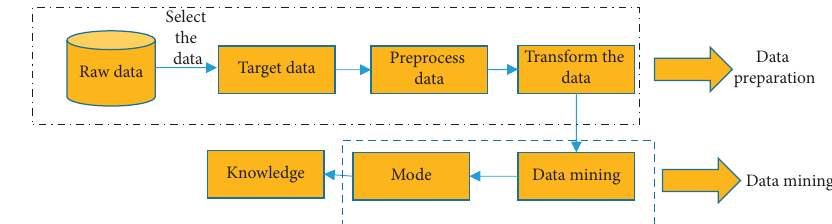
Figure 6: Detailed diagram of QS.